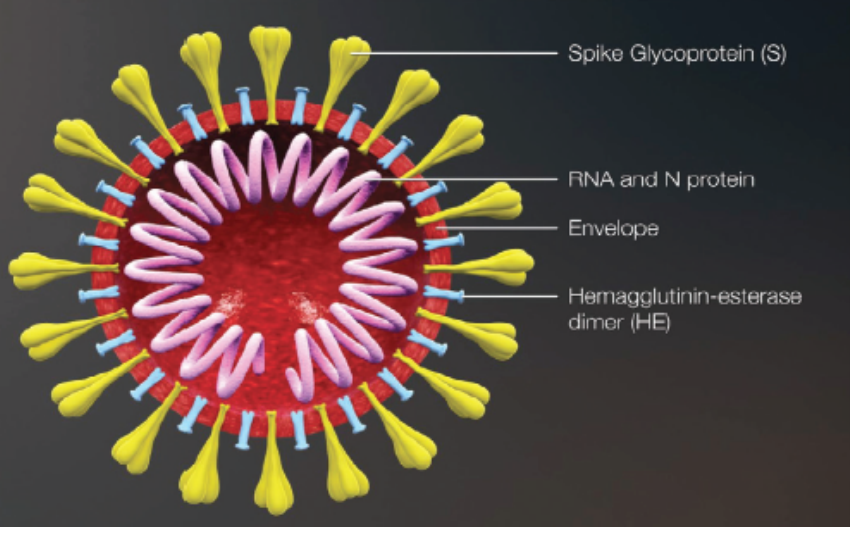
Figure 2. Coronavirus virion structure